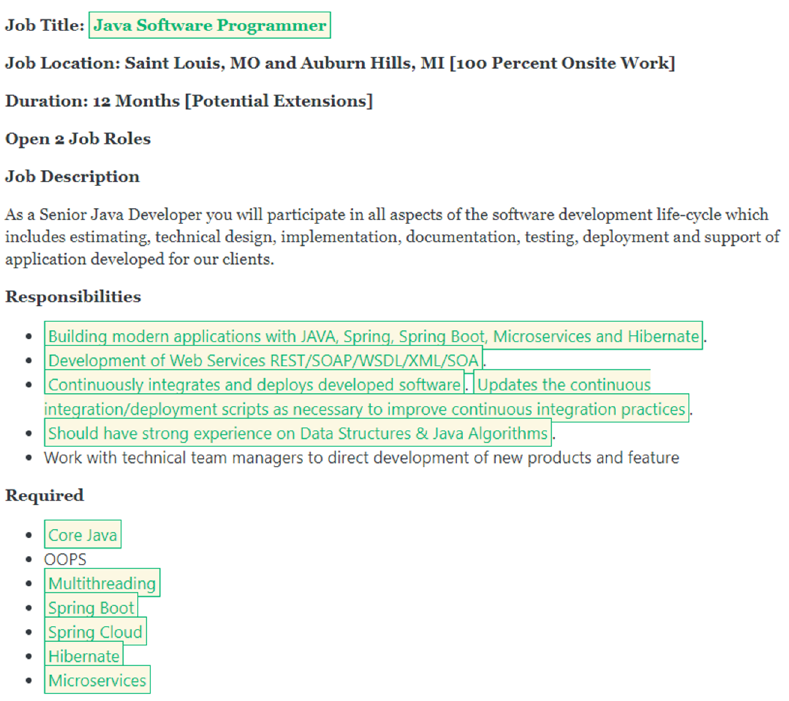
Figure 10. A job advertisement with two lists containing job requirements.